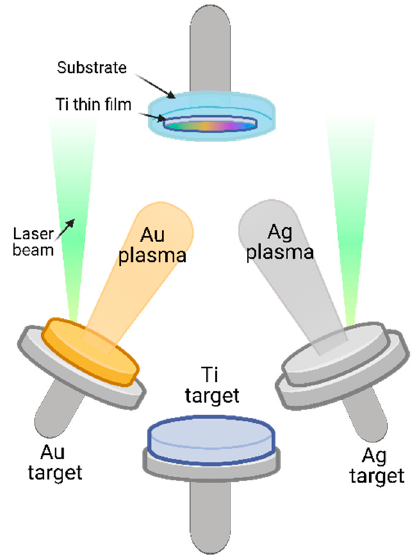
Figure 13. Titanium thin film (Ti) modification by Au and Ag.